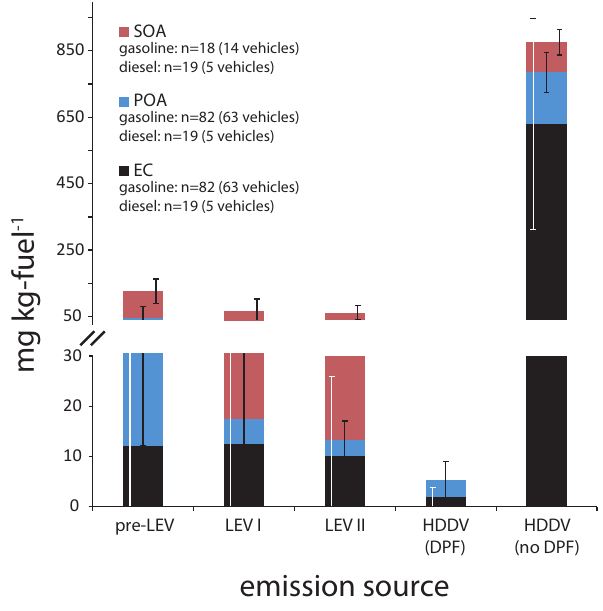
Fig. 8. Median EC, POA (in CVS) and SOA from light-duty gaso- line vehicles (LDGVs) and heavy-duty diesel vehicles (HDDVs). LDGV data were obtained during cold-start UC driving cycle ex- periments with a single CA summertime gasoline. HDDV data were obtained during UDDS driving cycle experiments with 3 different types of ULSD fuel (Gordon et al., 2013a). Median SOA values are calculated from the averages obtained by applying the ω = 0 and ω = 1 wall-loss correction approaches. Error bars represent ± 1 σ